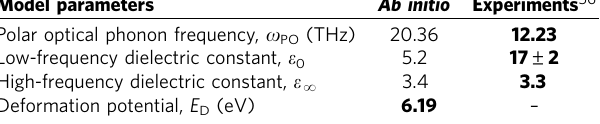
Table 1 | Input parameters to our AMSET model using ab initio calculations and using experimental values. The bold numbers indicate parameters that are used in our